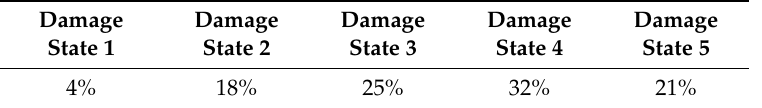
Table 10. Percentage of buildings in selected building data in a certain damage